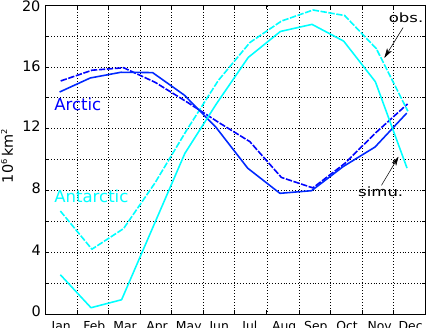
Figure 4. Mean seasonal cycle of sea ice extent (i.e. area inside the 15% concentration contour) in the Northern (in blue) and South- ern (in cyan) hemispheres from the ORCA2-LIM3 simulation (solid lines) and as derived from OSI-SAF observations (dashed lines). Units are in 10 6 km 2 .